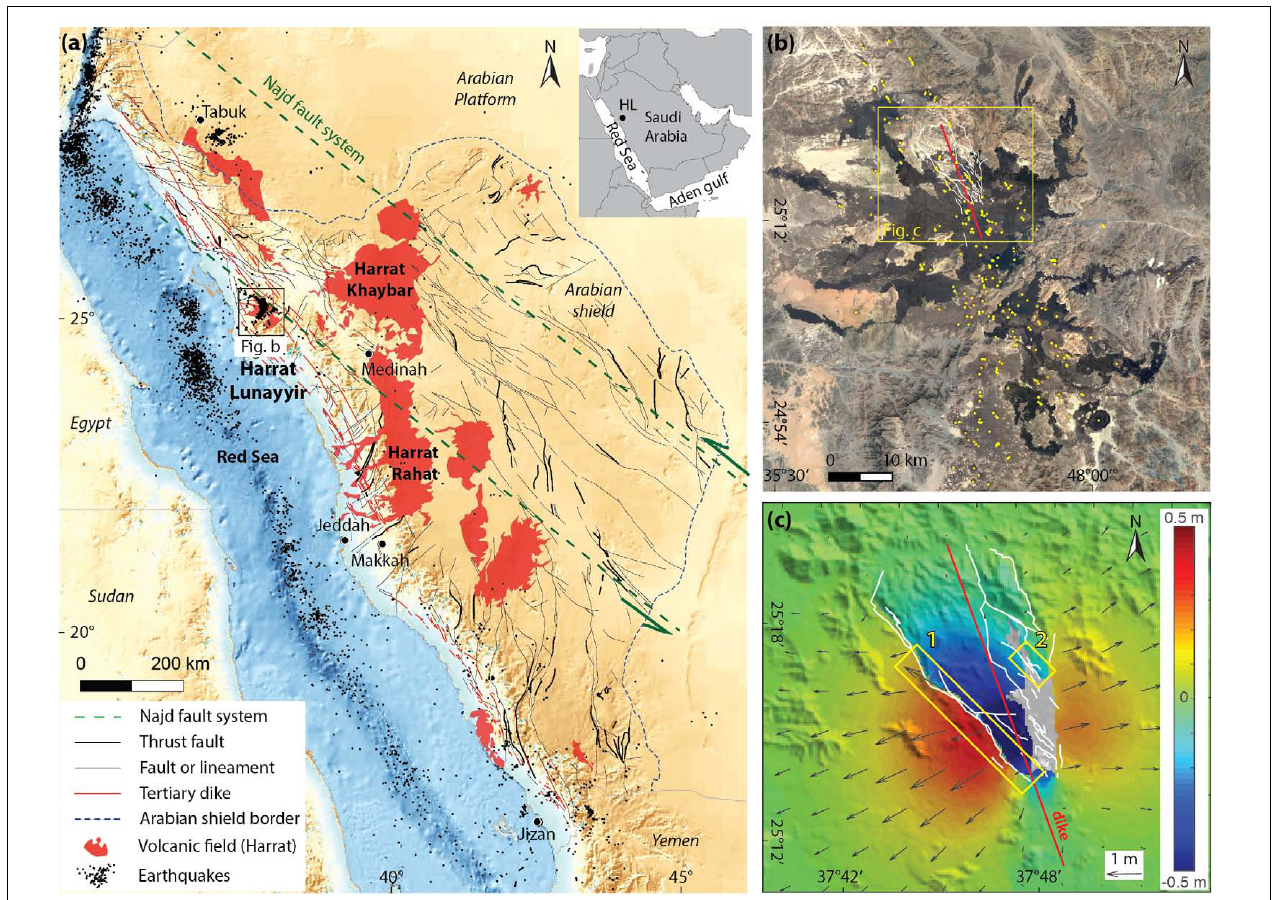
FIGURE 1 | Geological setting of Harrat Lunayyir and the 2009 dike intrusion. (a) Map of western Saudi Arabia and the Red Sea showing earthquakes (M > 2) 2007–2016 (small black dots), faults and lineaments (black and red lines) in the Arabian shield (Beziat and Bache, 1985) and the outlines (green dashed lines) of the left-lateral Najd fault zone (Stern, 1985). The inset shows the location of the Harrat Lunayyir volcanic field (HL) within Saudi Arabia. (b) Satellite image of Harrat Lunayyir showing volcanic cones (yellow dots), the inferred 2009 dike trace (red line; Pallister et al., 2010) and mapped surface fractures (white lines; Jónsson, 2012). Dark colors on the satellite image are quaternary lava flows. (c) 3D surface displacements induced by the 2009 dike intrusion as estimated from InSAR data (Jónsson, 2012) with arrows showing horizontal displacements and background colors vertical displacements. Yellow rectangles indicate the drone survey areas along the western fault (1) and the eastern fracture zone